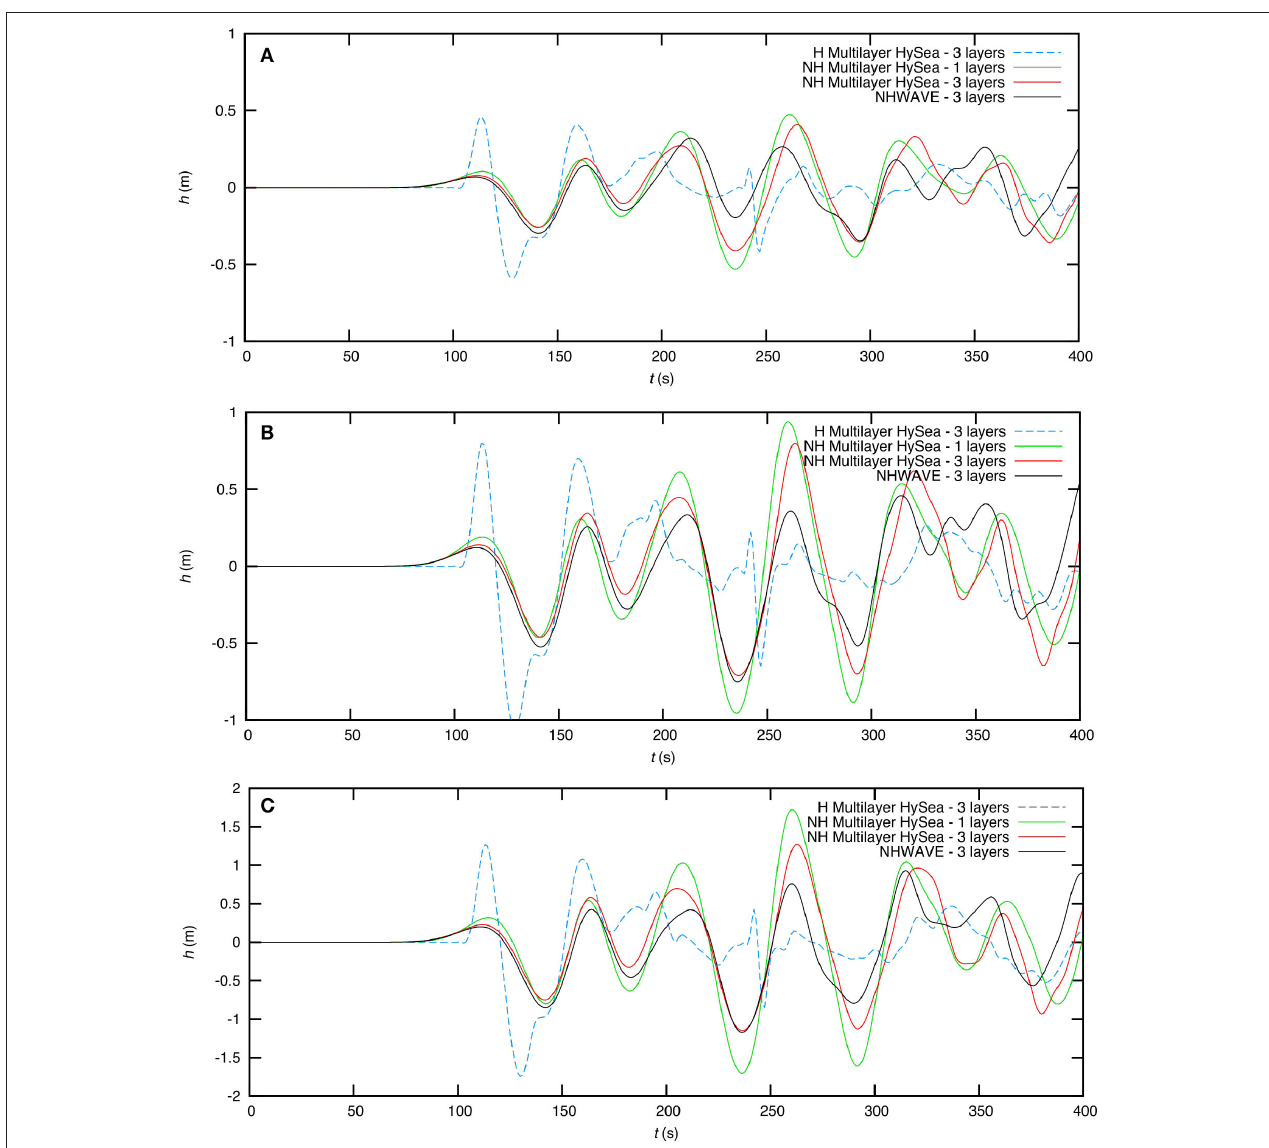
FIGURE 4 | Wave forms at gauge 4 simulated with different wave models with a rigid landslide (A) V = 7.1 × 10 6 m 3 , (B) V = 11.8 × 10 6 m 3 , and (C) V = 17.6 × 10 6 m 3